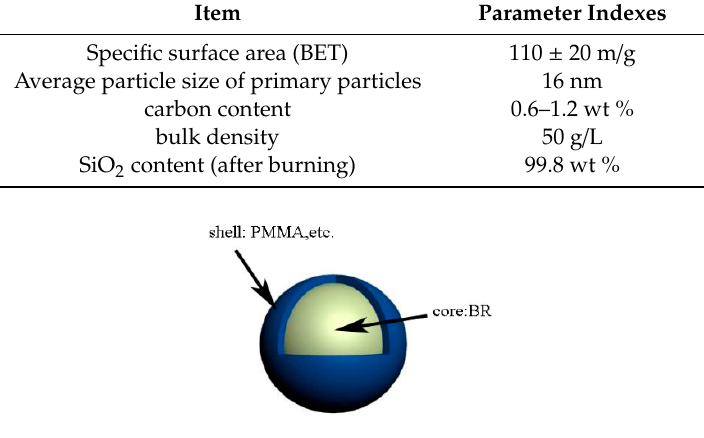
Figure 2. Filament winding process of NOL rings.